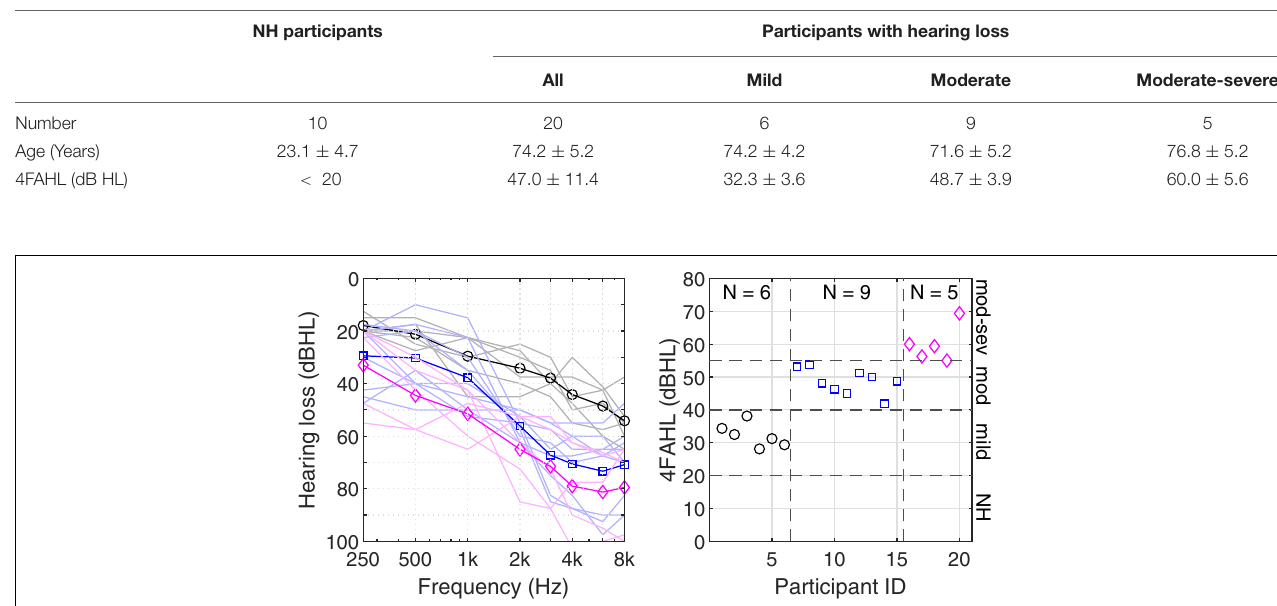
TABLE 1 | Descriptive statistics of the 10 NH participants and 20 participants with hearing loss.